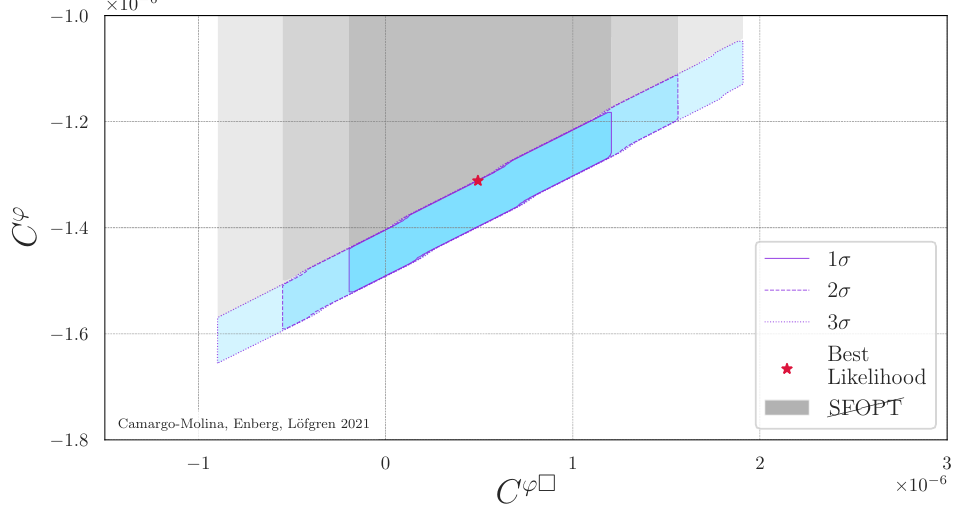
Figure 3 . Profile likelihood in the C ϕ (cid:3) – C ϕ plane. The intensity of the shading corresponds to the one-, two- and three- σ regions. The blue-shaded region leads to a strong FOPT and the gray-shaded region does not. We only show contours for the region with a first order transition. The point with the best likelihood and a strong FOPT is shown with a star. The lower area is empty as points there have λ < 0 and were not included in the study.